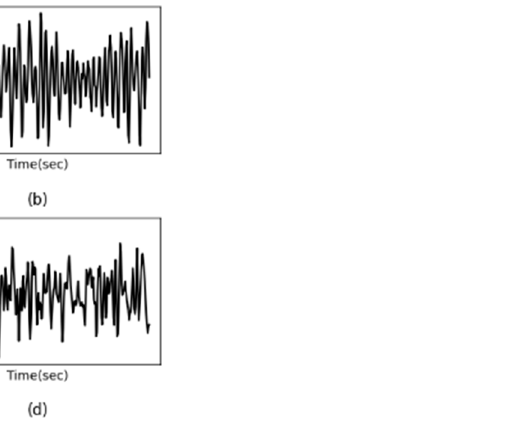
Figure 11. The acceleration response of the 10th accelerometer from Case 1 to 4. ( a – d ) represent Case 1 to 4.